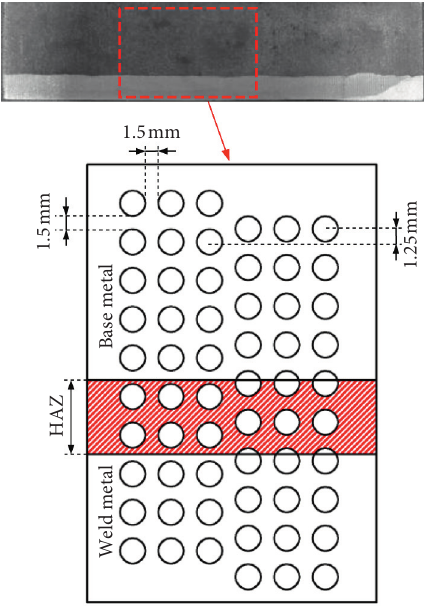
Figure 3: The distribution diagram of the continuous indentation test point.